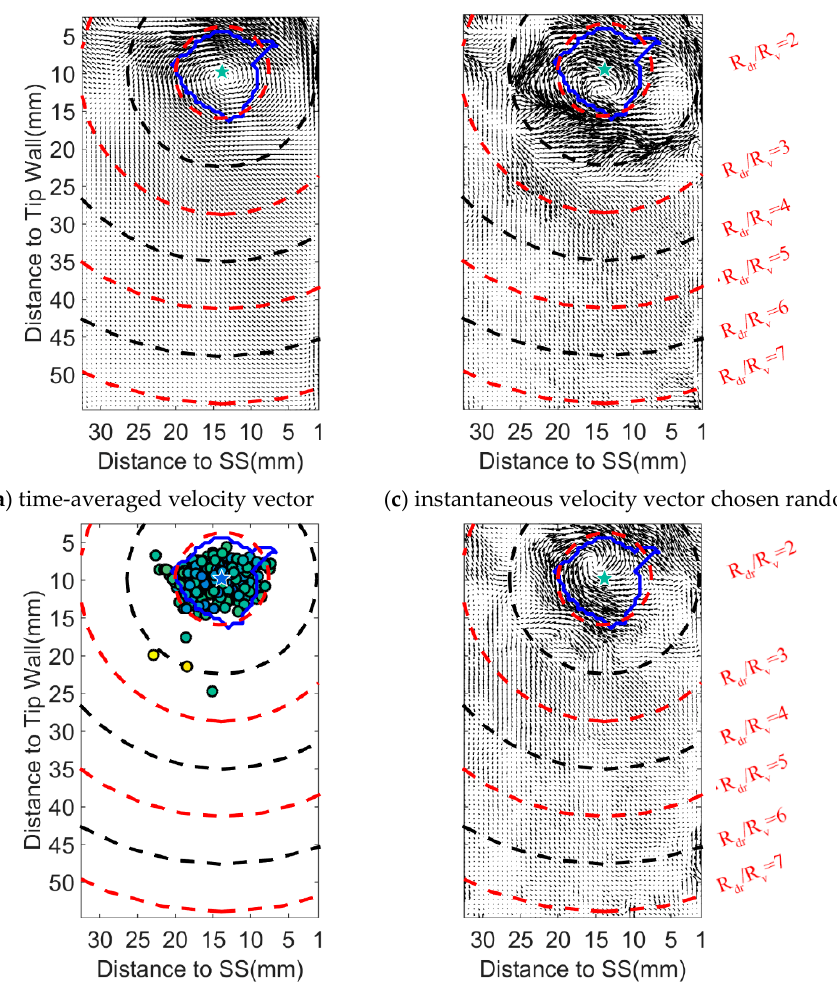
Figure 12. Decomposition regions at L/c = 1.1.